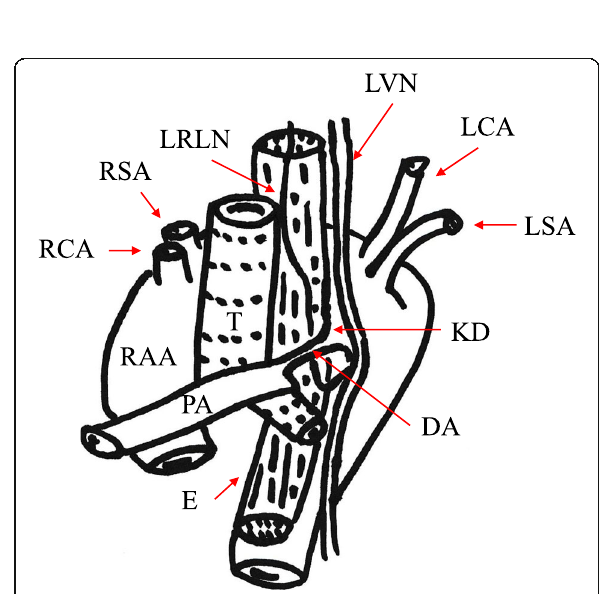
Fig. 4 Schematic illustration of the mediastinal structure of the present case. The trachea and esophagus were encircled completely by the right aortic arch. The ductus arteriosus connected Kommerell ’ s diverticulum to the pulmonary artery. The left recurrent laryngeal nerve passes behind the ductus arteriosus and ascends posteriorly. RAA: right aortic arch, KD: Kommerell ’ s diverticulum, DA: ductus arteriosus, LRLN: left recurrent laryngeal nerve, LVN: left vagus nerve, LSA: left subclavian artery, LCA: left common carotid artery, RSA: right subclavian artery, RCA: right common carotid artery, PA: pulmonary artery, E: esophagus, T: